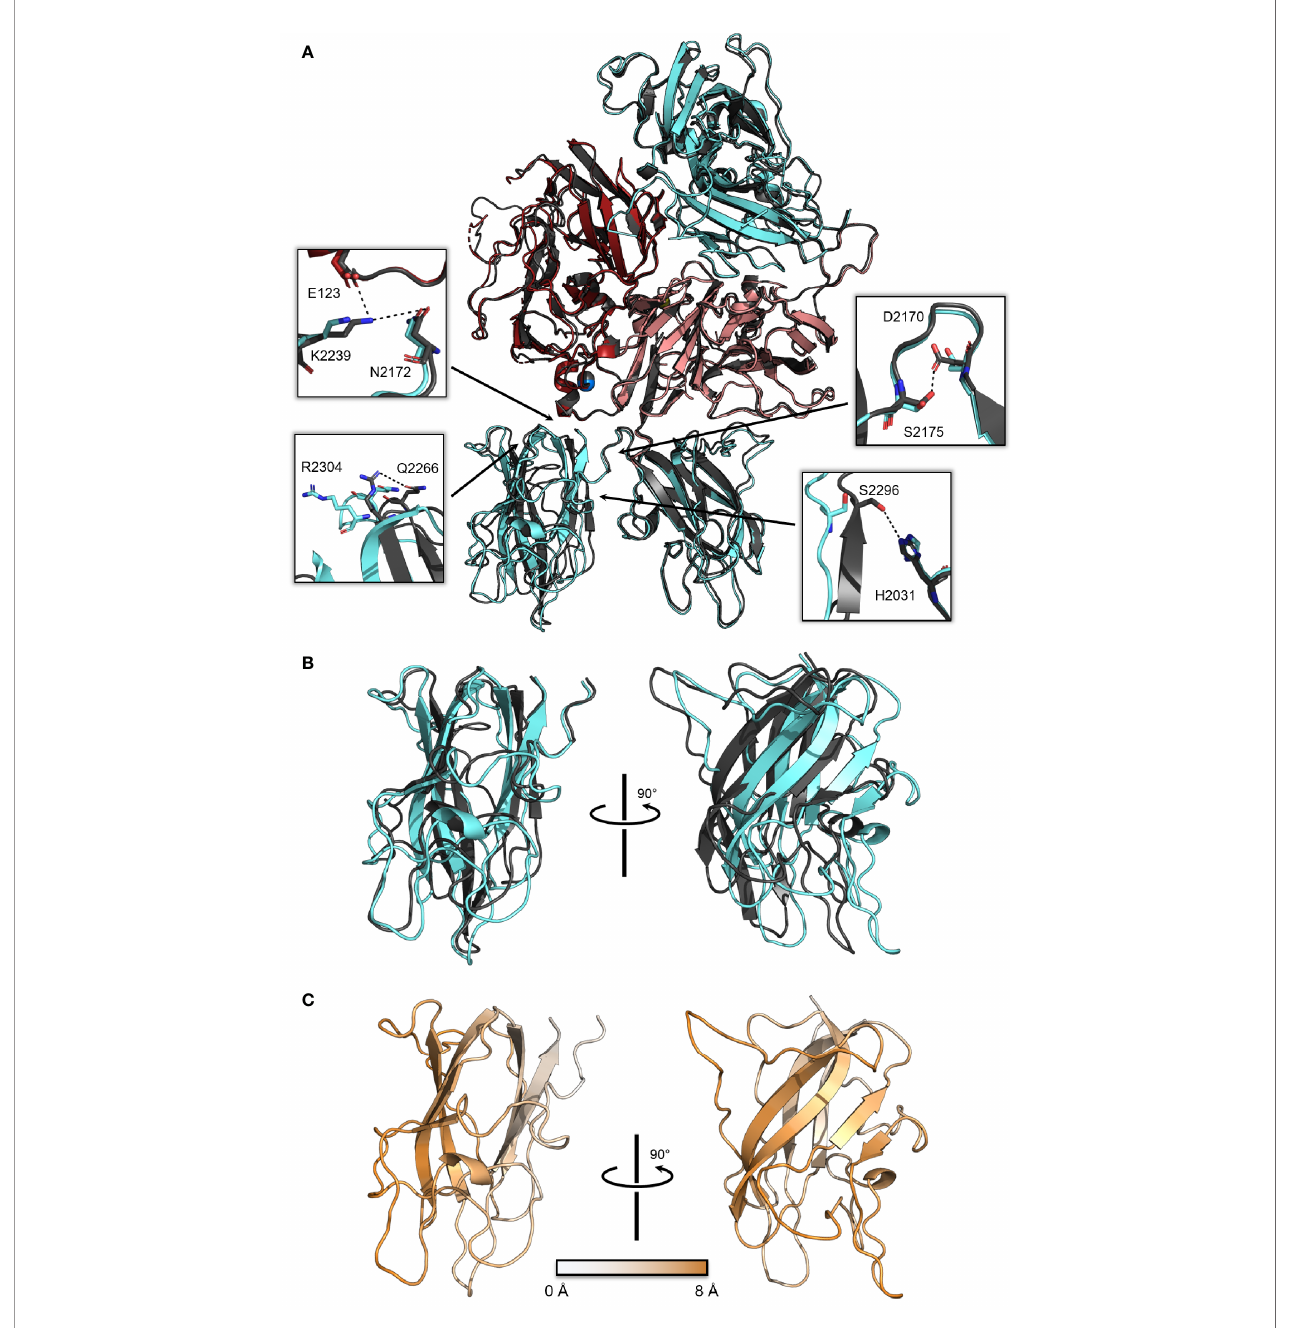
FIGURE 2 | Structural alignment of free ET3i and ET3i:G99 crystal structures. (A) Alignment of free ET3i (grey) and ET3i:G99 (A1, dark red; A3, pink; A2/C1/C2, cyan). Insets depict intramolecular contacts that are broken in the ET3i:G99 structure. (B) Alignment of the C2 domain from free ET3i structure (grey) and ET3i:G99 structure (cyan). (C) Structure of the C2 domain from the ET3i:G99 complex colored as a function of RMSD from alignment with free ET3i. White, low RMSD shifts; orange, large RMSD